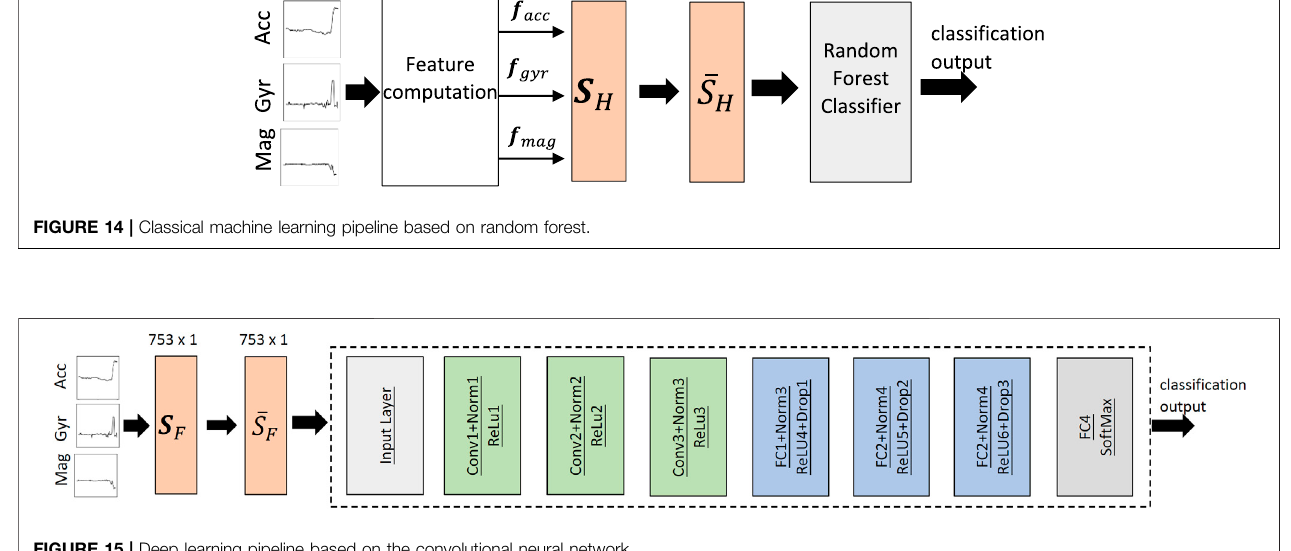
FIGURE 15 | Deep learning pipeline based on the convolutional neural network.